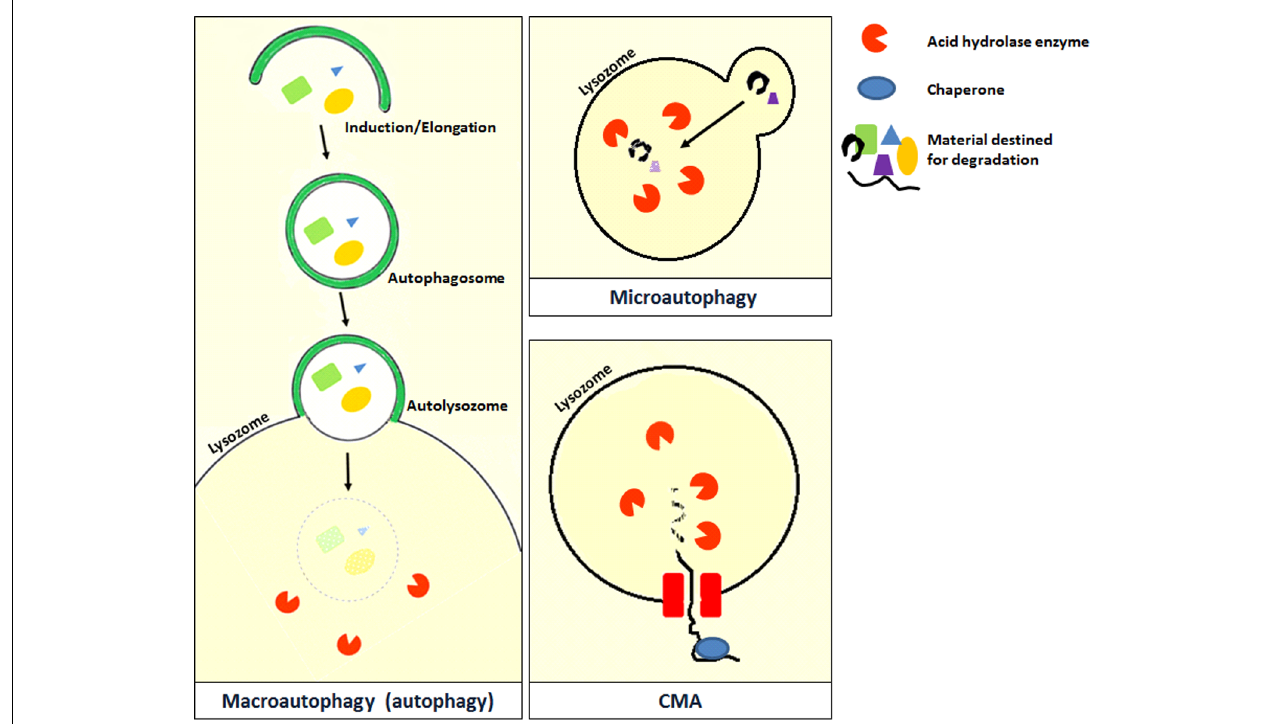
substrate is internalized through the translocation complex in the lysosomal membrane (Cuervo and Macian, 2012). CMA is considerably different from the other types of autophagy because it does not directly engulf the protein material but selectively transfers it individually into the lysosome (Kadian and Garg, 2012).The most extensively described type of autophagy in the literature is macroautophagy which is also referred to as autophagy in the literature. A review on macroautophagy (which will be referred to as autophagy from this point) is provided in this